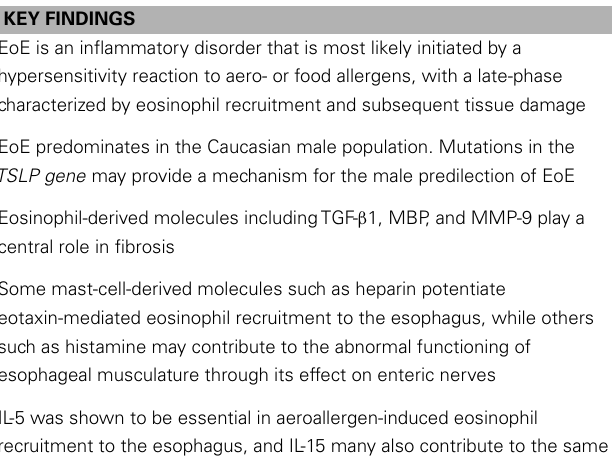
Table 1 | Key findings and current treatments